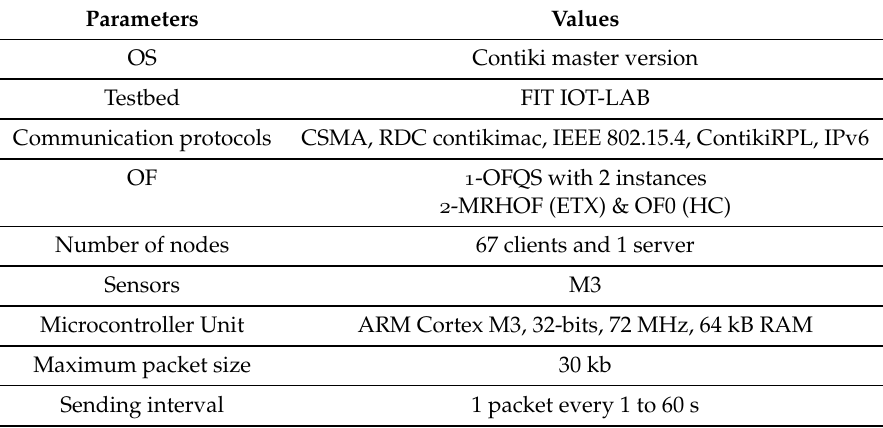
Table 3. Parameters of the